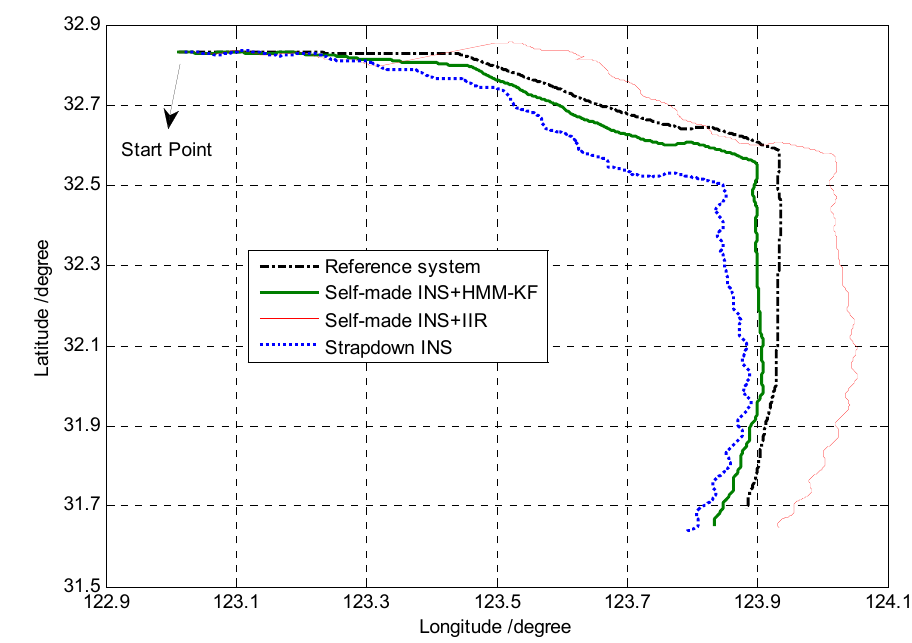
Figure 19. Trajectory comparison of the different navigation